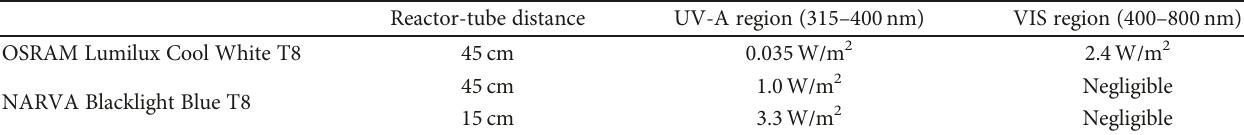
Figure 6: Schematic diagram of the experimental apparatus for NO degradation: (1) zero-air generator; (2) NO gas cylinder (8 ppm); (3) mass fl ow controllers; (4) gas washing bottle; (5) mixing chamber; (6) borosilicate-glass reactor with temperature and relative humidity probes; (7) lighting system; (8) bypass; (9) NO analyser; and (10) an extraction system. x Table 1: Illumination conditions